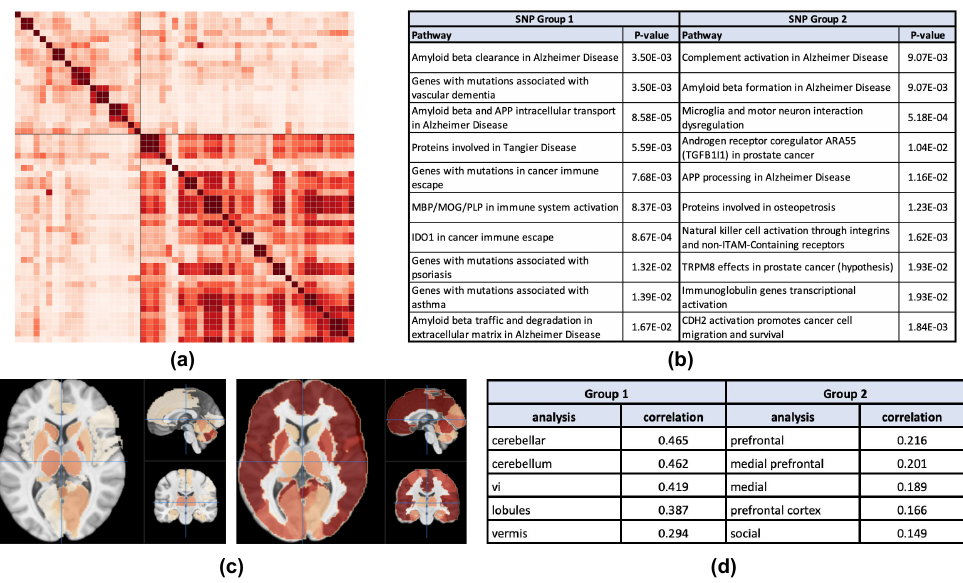
Figure 5. ( a ) Cosine SNP network derived from genetic analysis of the AV45 data in the LMCI vs. HC comparison. ( b ) The Elsevier pathway analysis from EnrichR of SNP group 1 (20 SNPs) and SNP group 2 (34 SNPs). ( c ) The average normalized brain significance maps corresponding to SNP group 1 (left) and SNP group 2 (right), respectively. ( d ) Neurosynth analysis results of the two brain maps shown in ( c